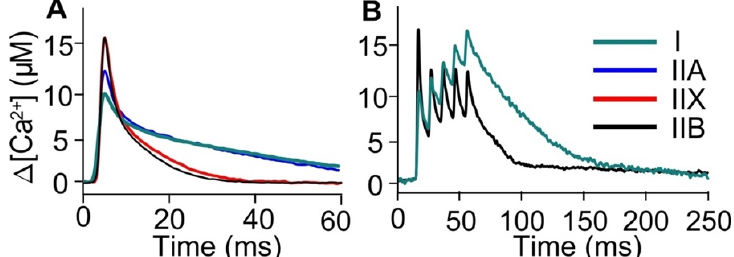
Figure 1. Experimental, calibrated measurements of [Ca 2+ ] during Ca 2+ transients elicited by a single and a train of AP (100 Hz) in mouse fibers at room temperature (21–23°C). All fibers were classified by myosin heavy chain direct determination in the original paper. Fluorescence recordings generated with Mag-Fluo-4 were used to obtain the ∆ [Ca 2+ ] in the sarcoplasm produced by a single AP in fiber types I (green), IIA (blue), IIX (red), and IIB (black) ( A ) and a train of 5 AP in fibers I and IIB ( B ).